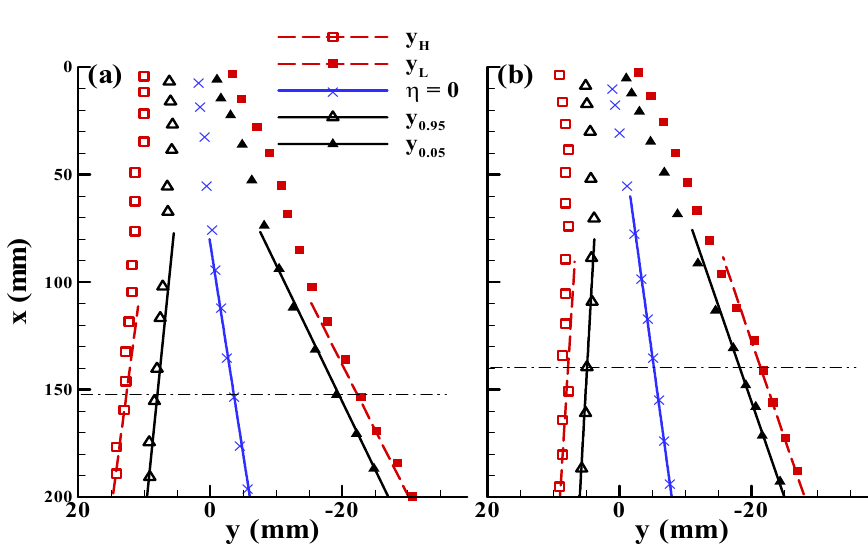
, y , y and y for two flow conditions of R = 0.67 and Re Figure 7 Distributions of y H L 0.95 0.05 θ = (a) 624, (b) 809. . As discussed before, y and y are determined on the basis of mean velocity field and y L 0.95 0.05 and their information can be used to estimate the production ( V) term only in Eq. (5). In contrast, information of y and y , which are determined on the basis of mean shear-induced H L vorticity, can be used to estimate all required source terms in Eq. (5). Thus, justifying the achievement of self-preserving state based on the information of y and y makes more H L and y Evolution of four different length sense than based on the information of y 0.95 0.05. scales of mixing layer ( l , l , δ , θ ) are plotted in Fig. 8. It shows that l > l > δ > θ . Moreover, u u ω ω for those length scales who are defined on the basis of the mean velocity field such as l , δ u and θ , they start to exhibit linear growth rates at around the same stream-wise location (x ≅ 100